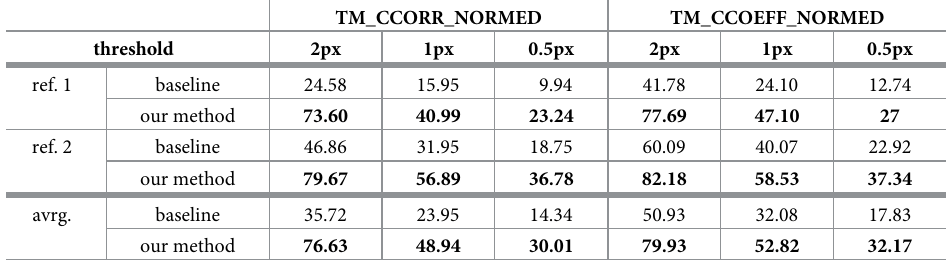
Table 2. Mean reconstruction rates [%] of our method and baseline. Reconstruction rates are given in percent recon- structed of a volume. Bold is the best rates for each parameter set.